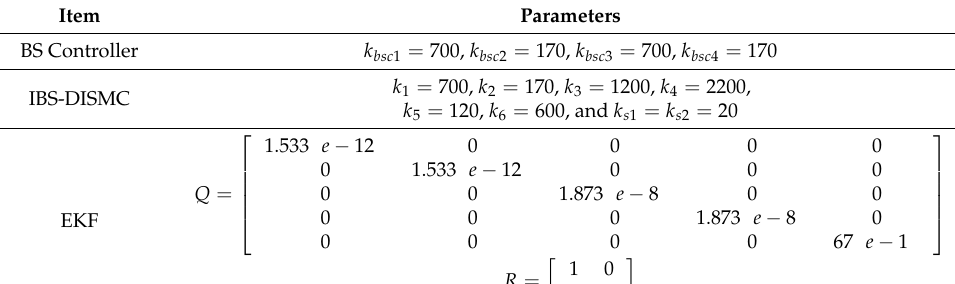
Table 2. The parameters of the reported approaches.